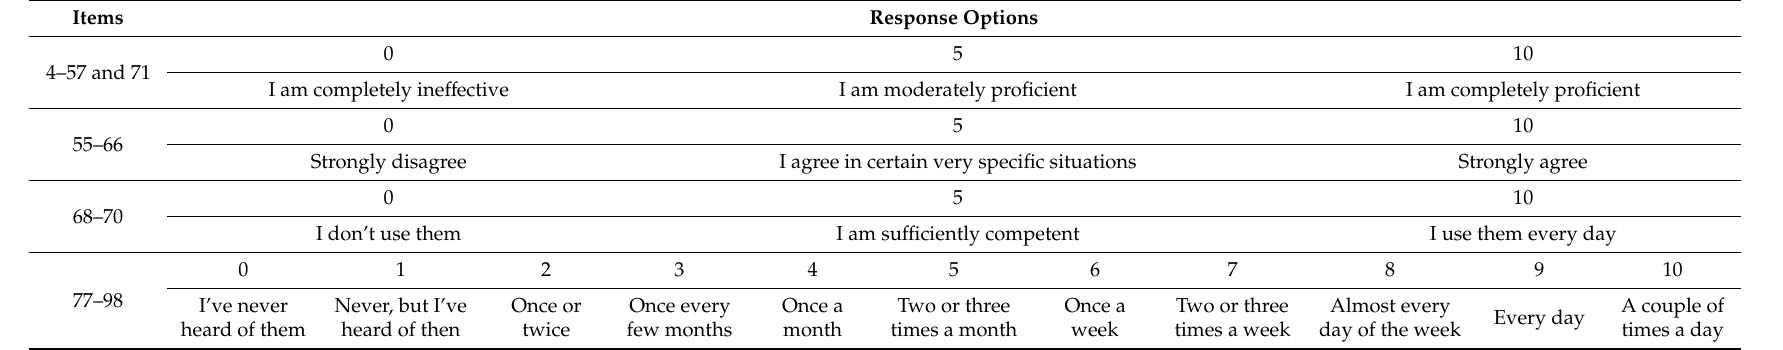
Table 1. Item response options in the